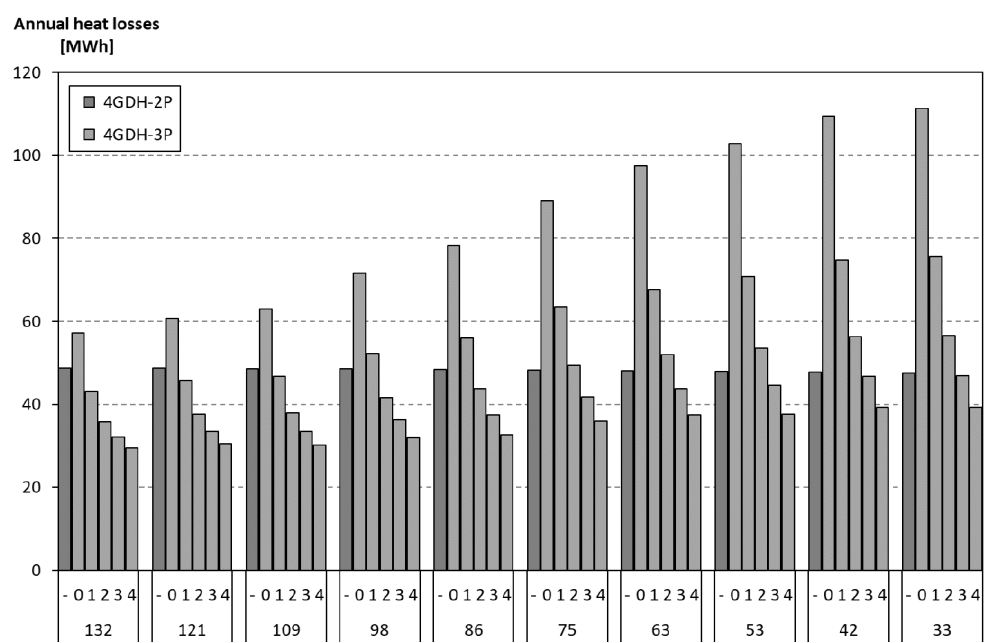
Figure 8. Annual heat loss for the case area at NTU (8/1) for heat exchangers in substations and radiators for ten different annual specific heat demands (132–33) [kWh/m 2 , a]. The dash (-) denotes performance with the current two-pipe distribution (4GDH-2P), while 0–4 denote the three-pipe distributions with the corresponding downward displacement of standard sizes for the third pipe. Figure data are valid for pipes with three insulation series, according to [17].